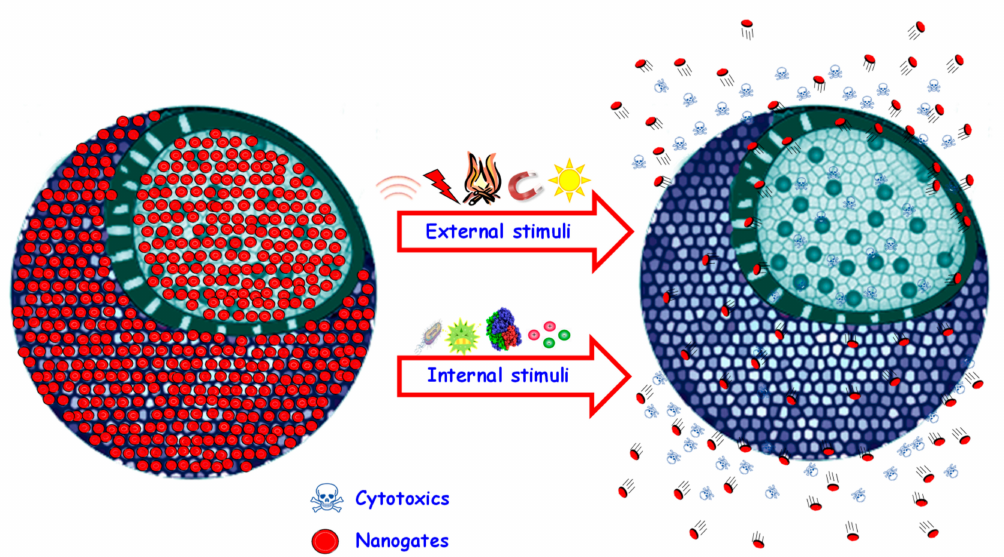
Figure 2. Schematic representation of stimuli-responsive MSNs. In response to the